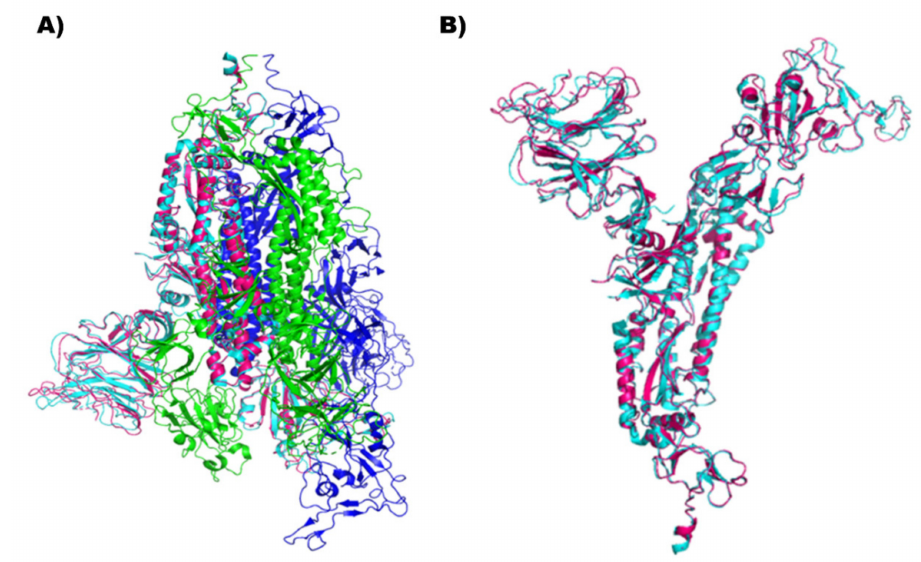
Figure 3. Superimposed snapshot of the modelled and the crystal structure (PDB: 7W92) of the Delta S RBD. ( A ) S RBD crystal structure of 7W92, a homotrimer, with the chains A, B, and C highlighted in blue, cyan, and green, respectively. Here, the modeled Delta S RBD aligned with the B chain of 7W92 after superimposition is highlighted in cyan and pink. ( B ) Enlarged view of the superimposed structures of modeled Delta S RBD on 7W92, chain B crystal structure, highlighted in cyan and pink, respectively.